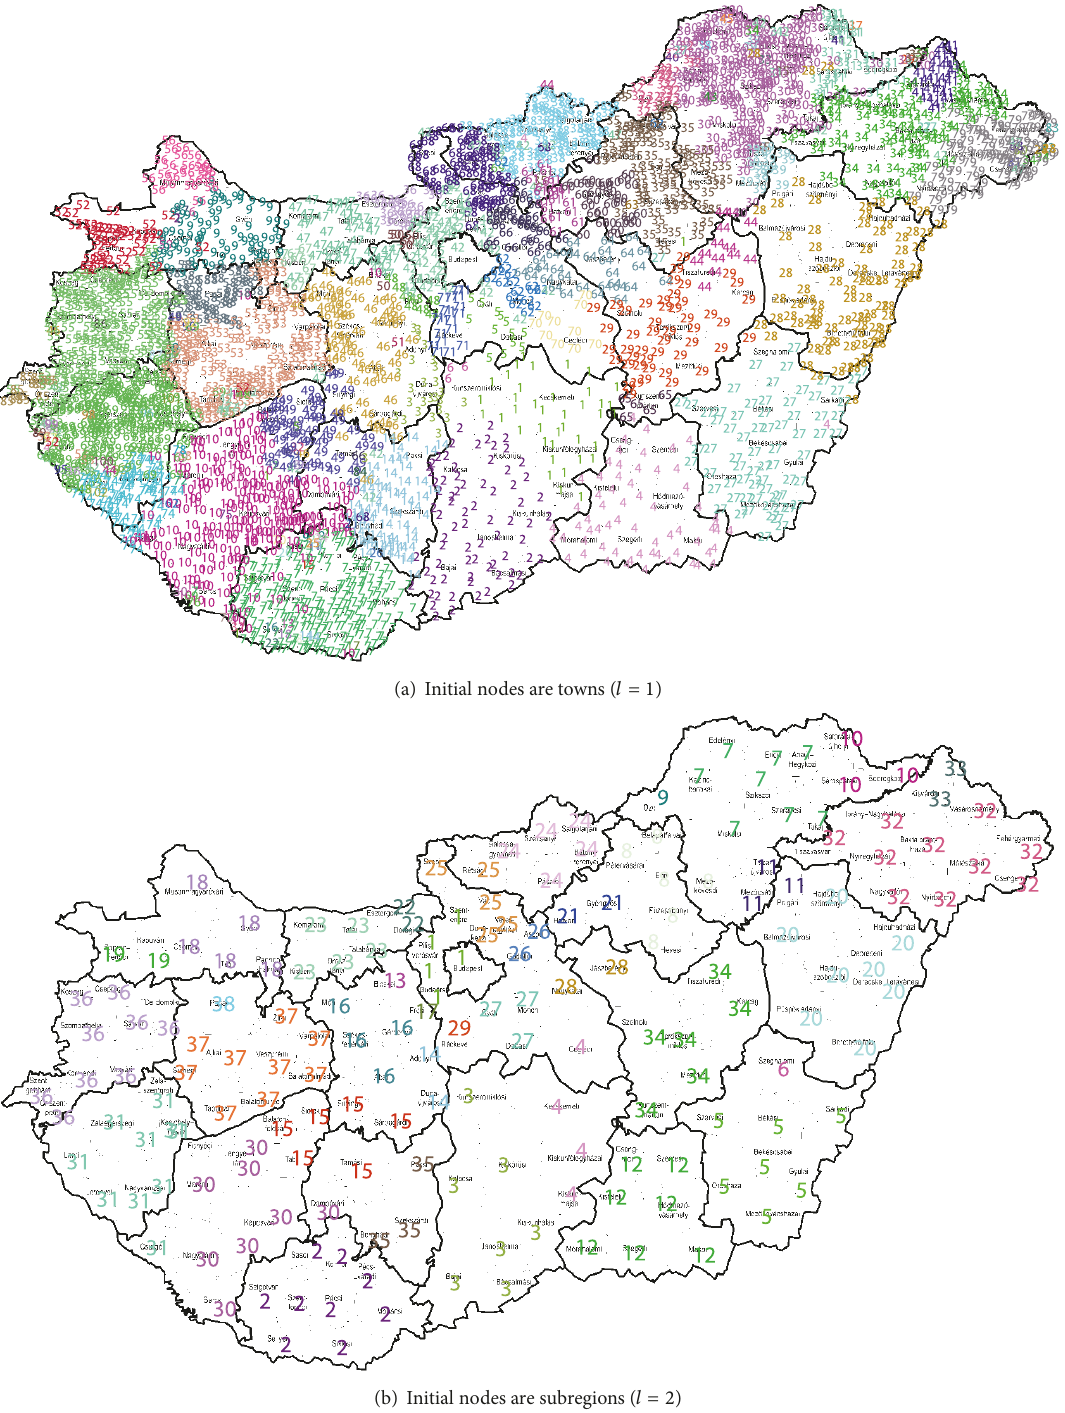
Figure 9: Communities formed by the Louvain method and Newman-Girvan (NG) null model ( 𝐼 𝑖 = 𝑘 𝑜𝑢𝑡 𝑖 and 𝐼 𝑗 = 𝑘 𝑖𝑛 𝑗 ) reflect the settlement hierarchy as the resultant communities are almost identical to the